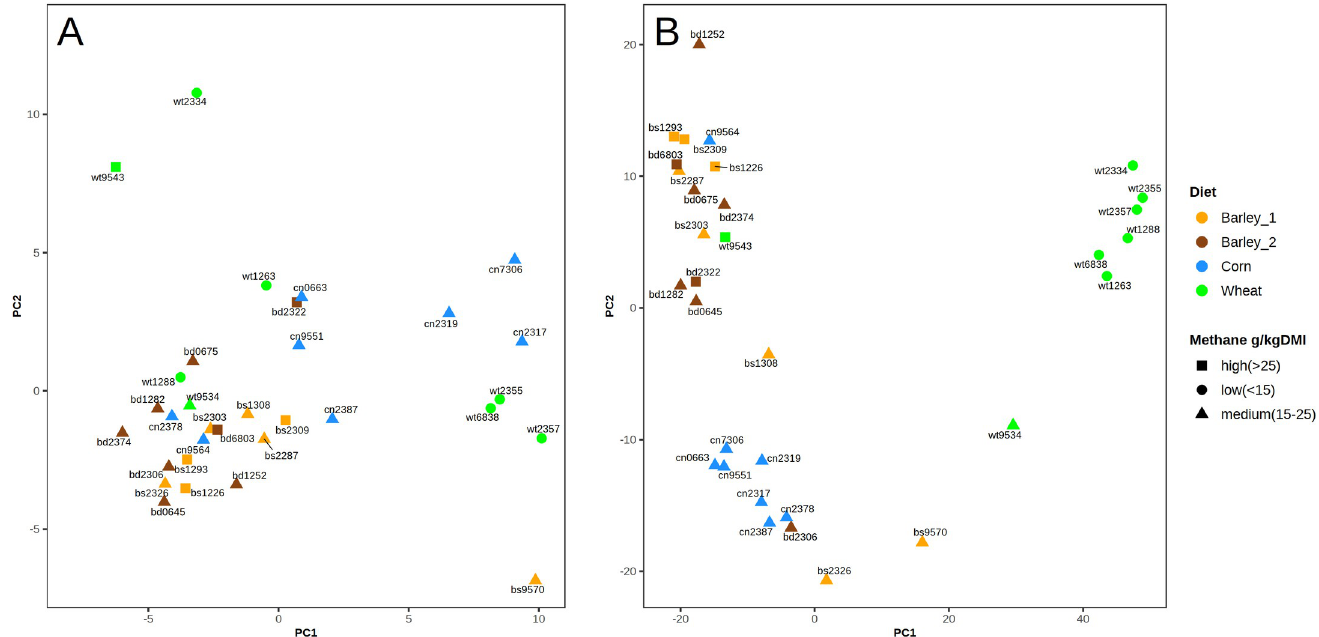
Fig 3. PCA. Principal Components Analysis of rumen sequences using: A: abundance of families derived from unclustered DNA sequences aligned to the Silva 16s taxonomy database, B: abundance of OTU created using the Swarm2 clustering algorithm. For this analysis the cows were assigned to methane yield groups (g CH4/ kg dry matter intake, MeY) as follows: low (MeY < 15), medium (15 < MeY < 25) or high (MeY > 25). Also see S1B Fig.